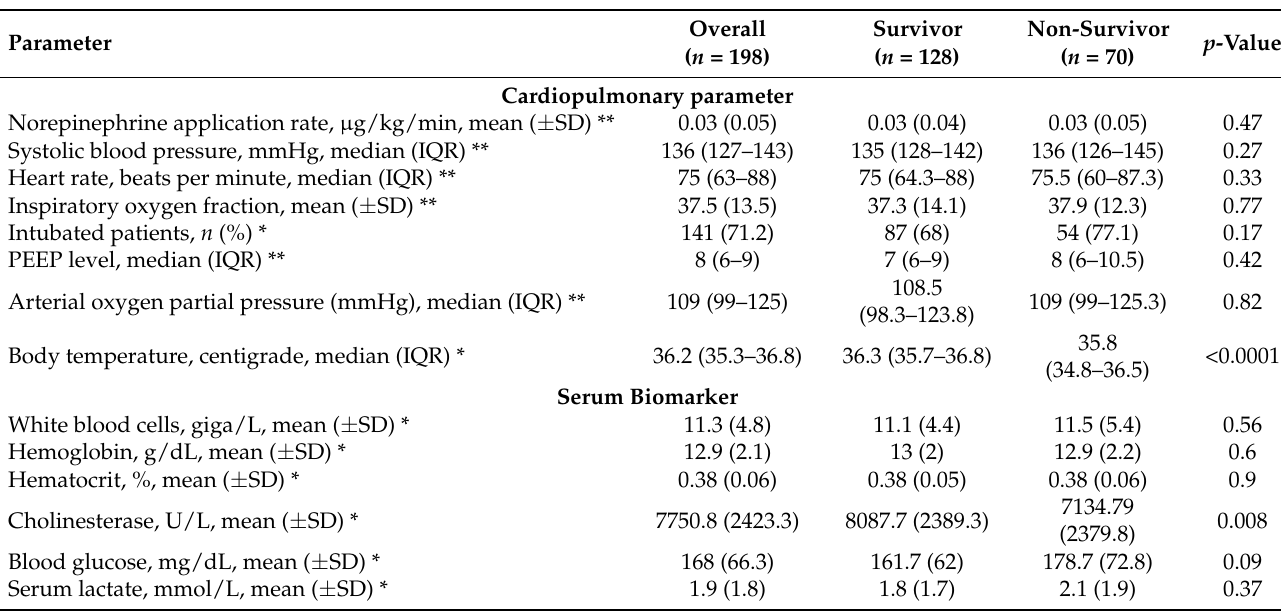
Table 2. Clinical, radiological and treatment parameter of the study